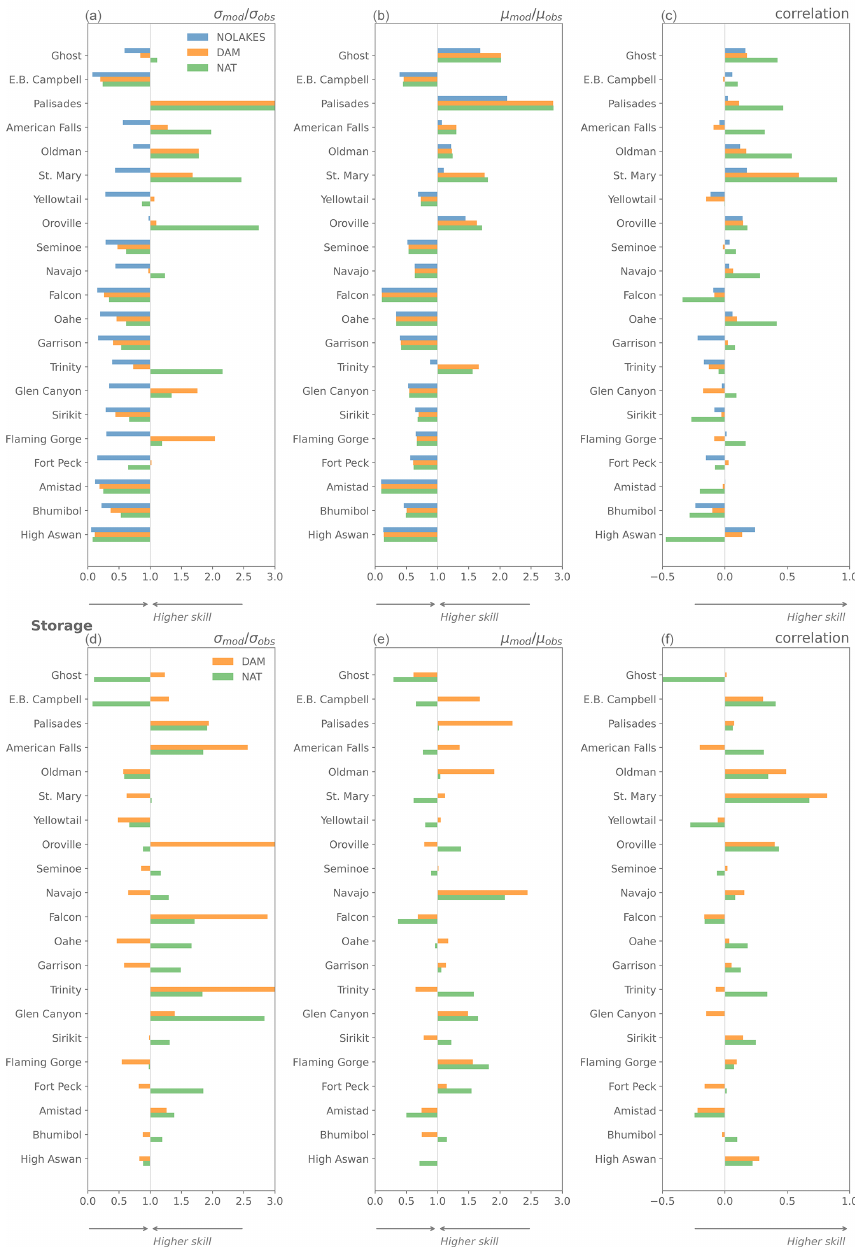
Figure A4. Performance for mizuRoute simulations for outflow (a–c) and storage (d–f) compared to reservoir observations using the KGE terms: variability error ( σ mod , a , c ), mean bias ( µ mod , b , e ) and correlation (c, f) . σ obs µ obs